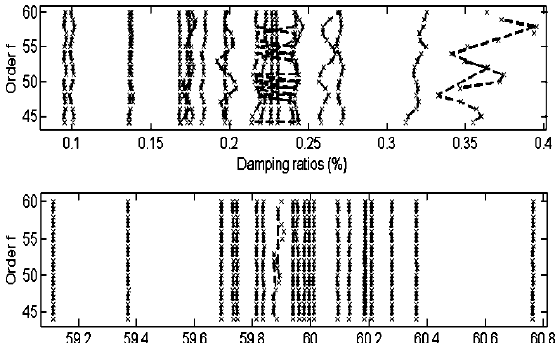
Fig.3 Stability diagrams on damping and eigenfrequencies